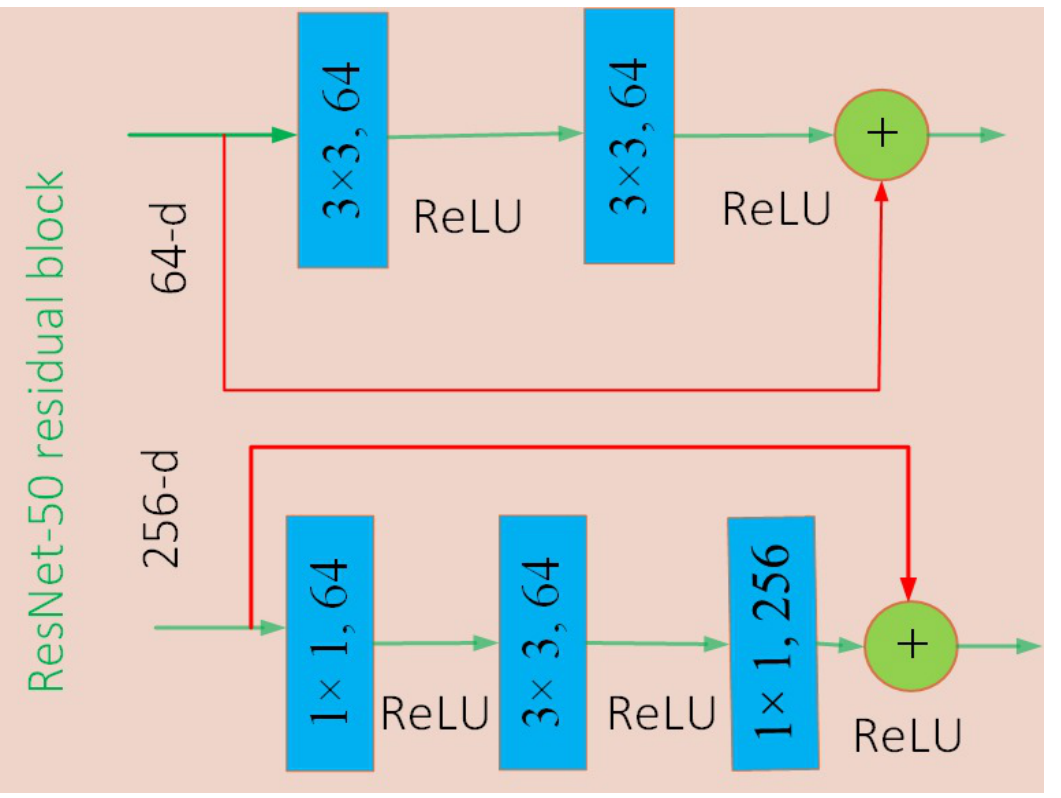
Figure 1. ResNet-50